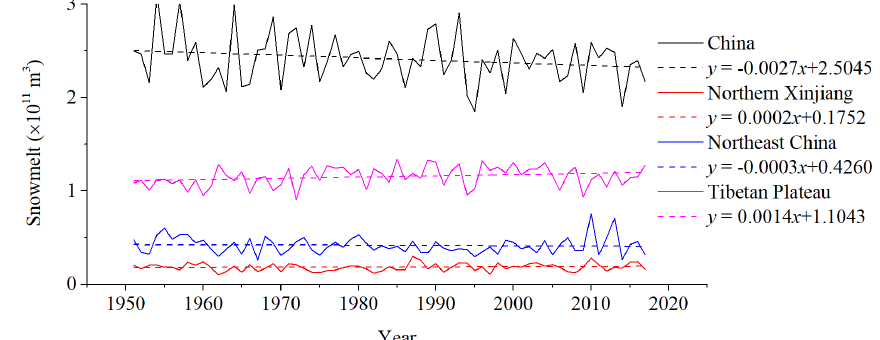
Figure 9. Interannual variability in the mean annual snowmelt in China and its three main stable snow cover regions from 1951 to 2017.